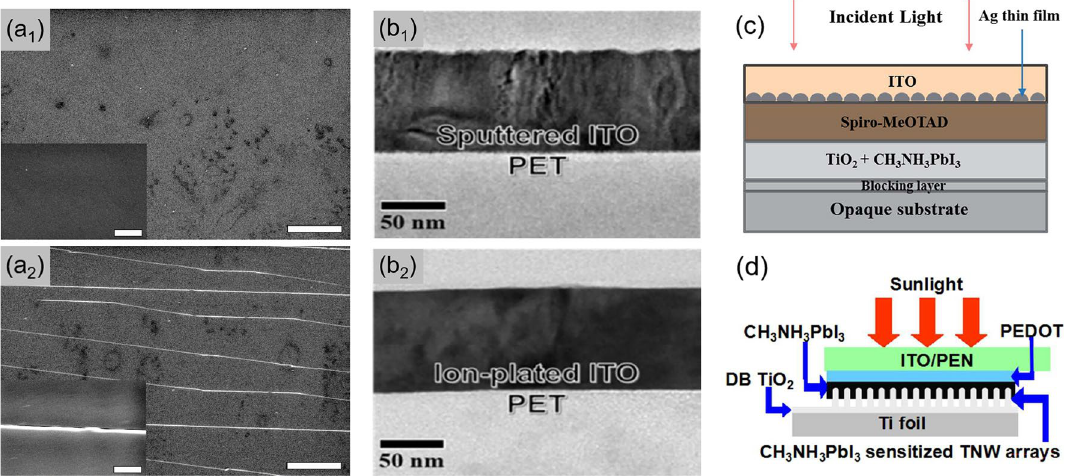
Fig. 1 SEM images of PET/ITO substrate before ( a 1 ) and after ( a 2 ) 2200 bending cycles, and the scale bars are 50 μm (main) and 5 μm (inset), respectively. Reproduced with permission from Ref. [43]. Copyright 2015, Royal Society of Chemistry. Cross-section images about the sputtered ITO film ( b 1 ) and ion-plated ITO film ( b 2 ). Reproduced with permission from Ref. [52]. Copyright 2018, Royal Society of Chemistry. c Device structure of FPSCs with sputtered ITO top electrode. Reproduced with permission from Ref. [58]. Copyright 2015, Royal Society of Chemistry. d Device schematic of FPSCs with laminated ITO/PEN top electrode. Reproduced with permission from Ref. [59]. Copyright 2016, Royal Soci- ety of